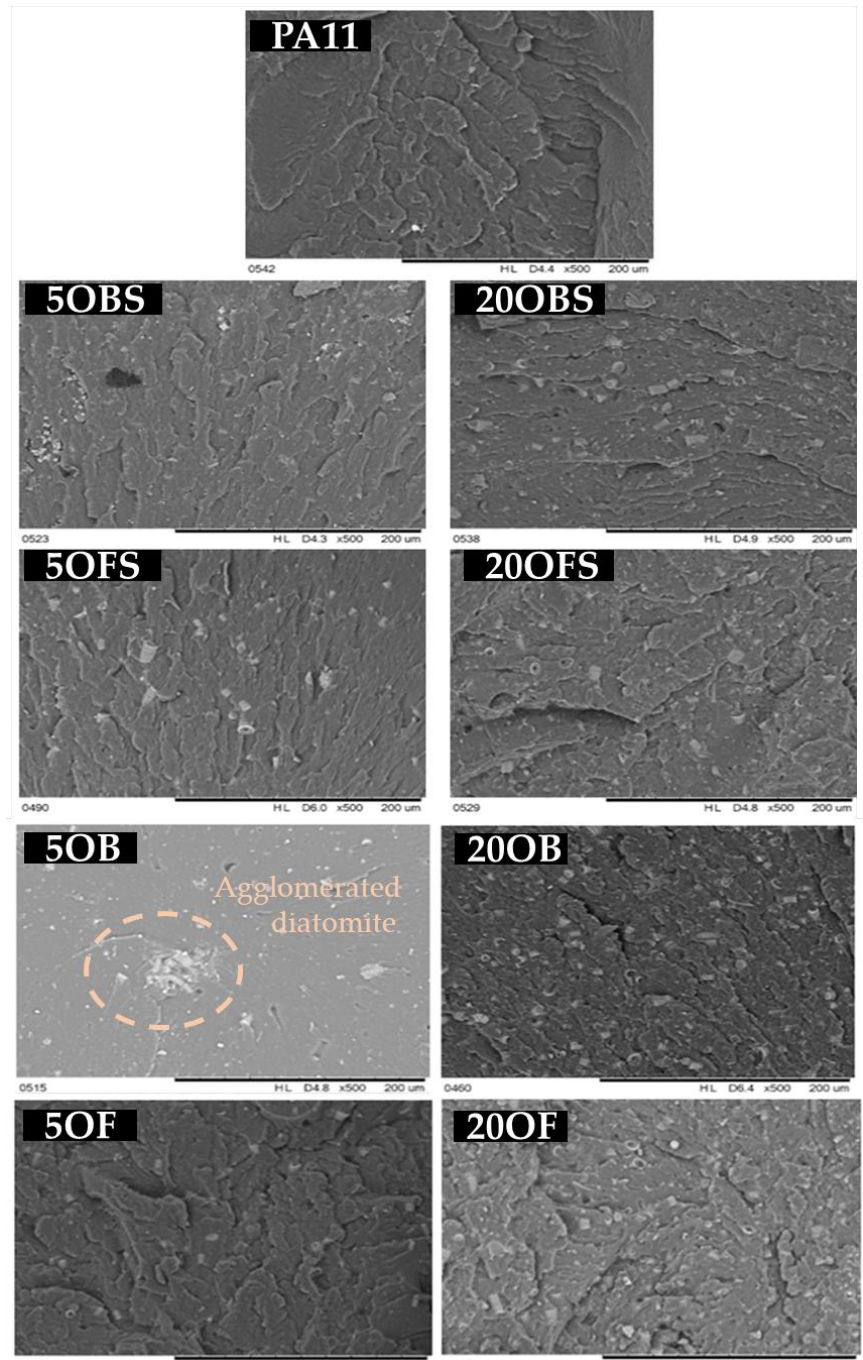
Figure 18. SEM images of composite fractures after testing the notch impact test; comparison to the systems without silane APTES.